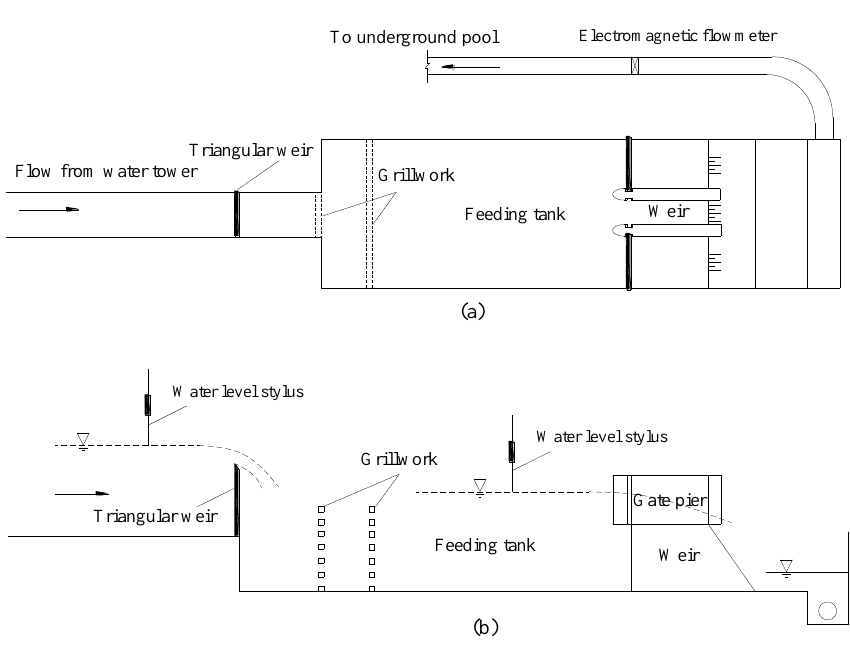
Figure 1. Experimental setup: ( a ) plane view; ( b ) side view.